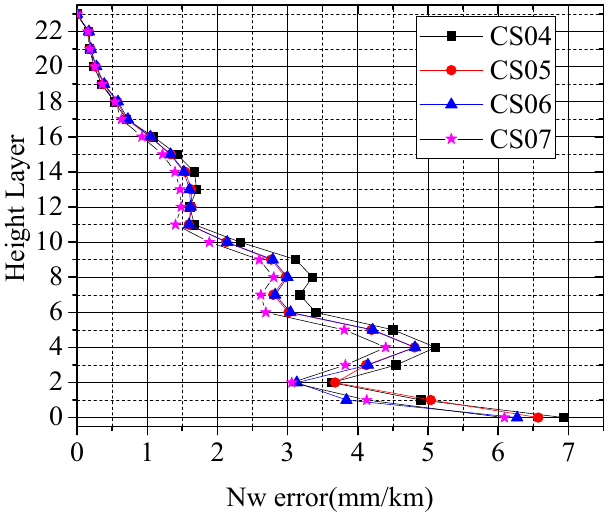
Figure 8. Comparisons of wet refractivity error profiles for CS04, CS05, CS06, and CS07 for a study of influences of ground-based station distribution and horizontal resolution on tomography.